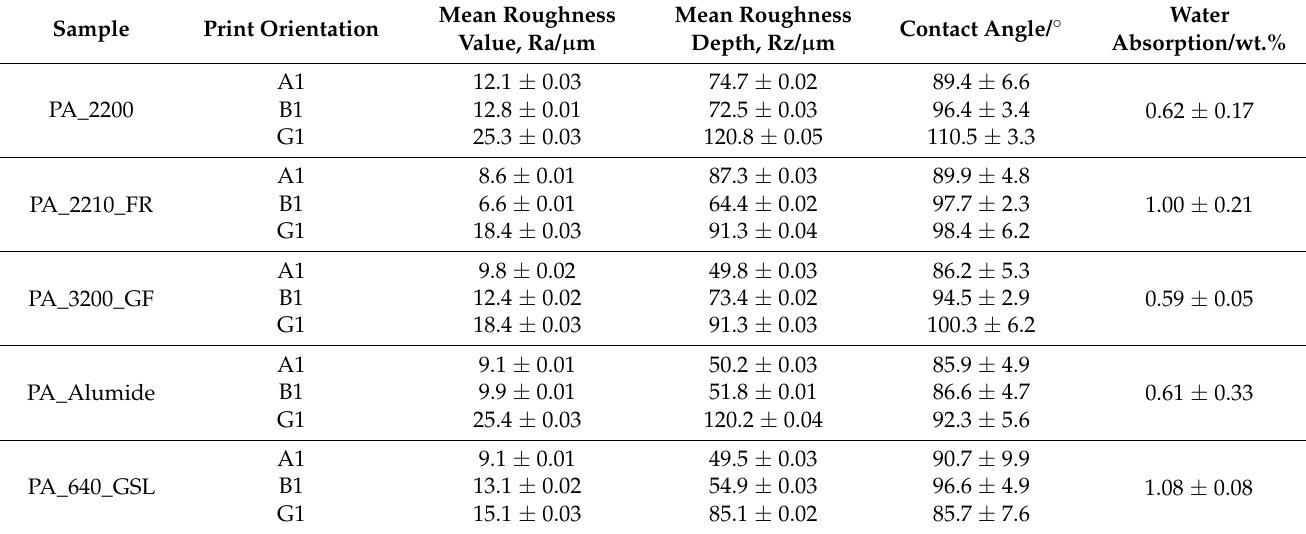
Table 6. Results for roughness and contact angle